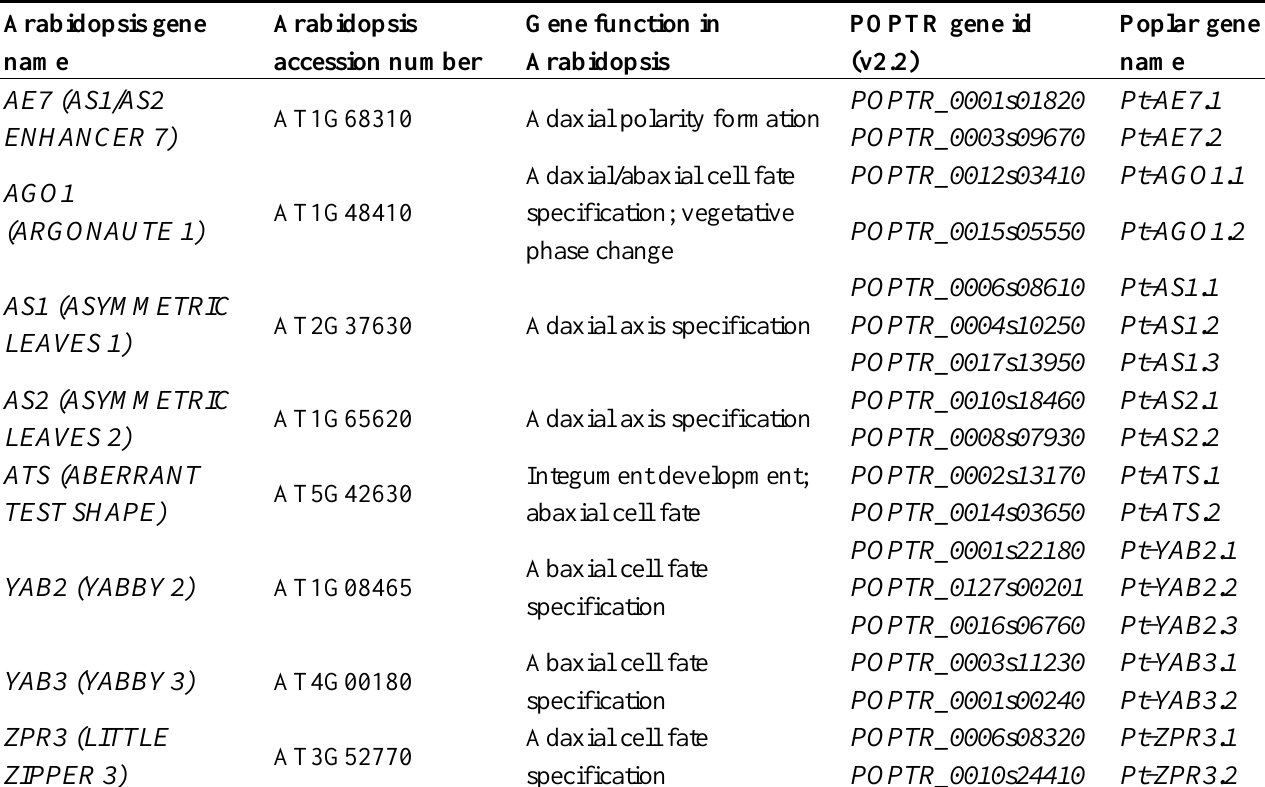
Table 1. Arabidopsis genes names and identified putative P. trichocarpa orthologs, including poplar gene id (for version 2.2 of the genome) and gene name for 18 poplar genes selected for detailed study, out of 84 initially screened. Gene function in Arabidopsis , from various references (cited within text or TAIR), is also